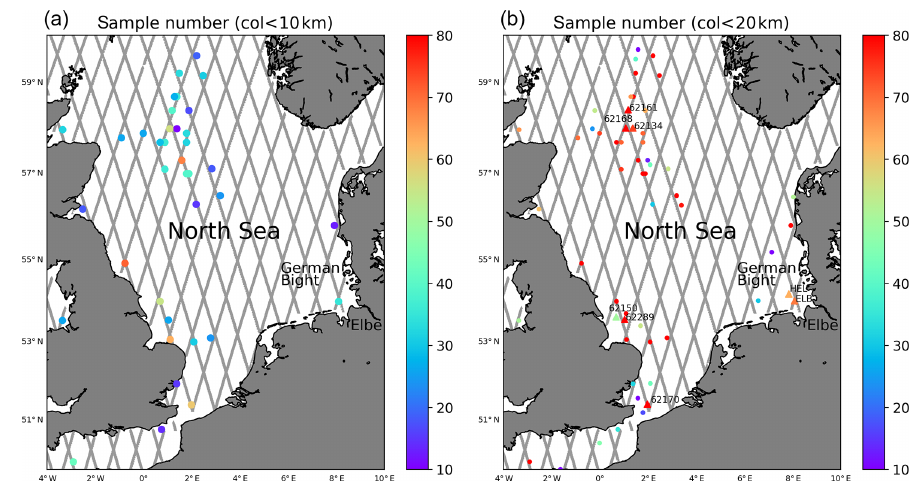
Figure 2. (a) Map showing Sentinel-3A altimeter tracks together with wave observation platforms with less than 10km distance to satellite measurements. The colour coding refers to the number of obtained collocated measurements in the period April 2016 to August 2017. (b) The same as (a) with a collocation distance of